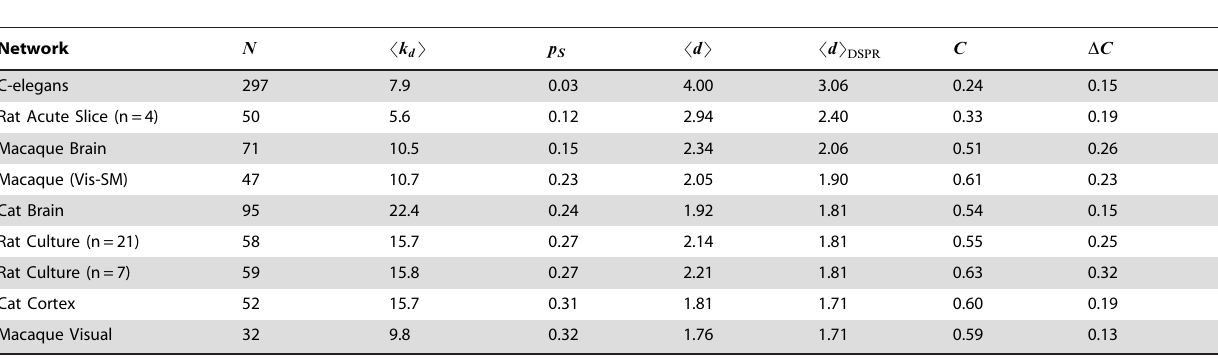
Table 1. Network properties for some known neural systems: C-elegans [44]; Rat Cortex in vitro , Acute Slice (average of n ~ 4 datasets, binned at 4 ms ) [31]; Macaque Brain [61]; Macaque Visual and Somatosensory Cortex [61]; Cat Brain [62]; Rat Cortex in vitro , Cultures n ~ 21 ð Þ , binned at 4 ms [29,30]; Rat Cortex in vitro Cultures n ~ 7 ð Þ , gathered at 1 ms and re-binned at 2 ms [30]; Cat Cortex [62]; Macaque Visual Cortex